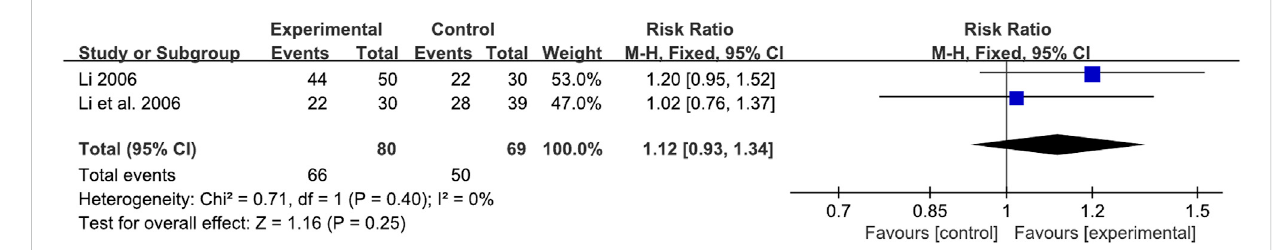
FIGURE 7 Forest plot of the comparison for total clinical ef fi cacy rate between the DZXYZ and WM groups.